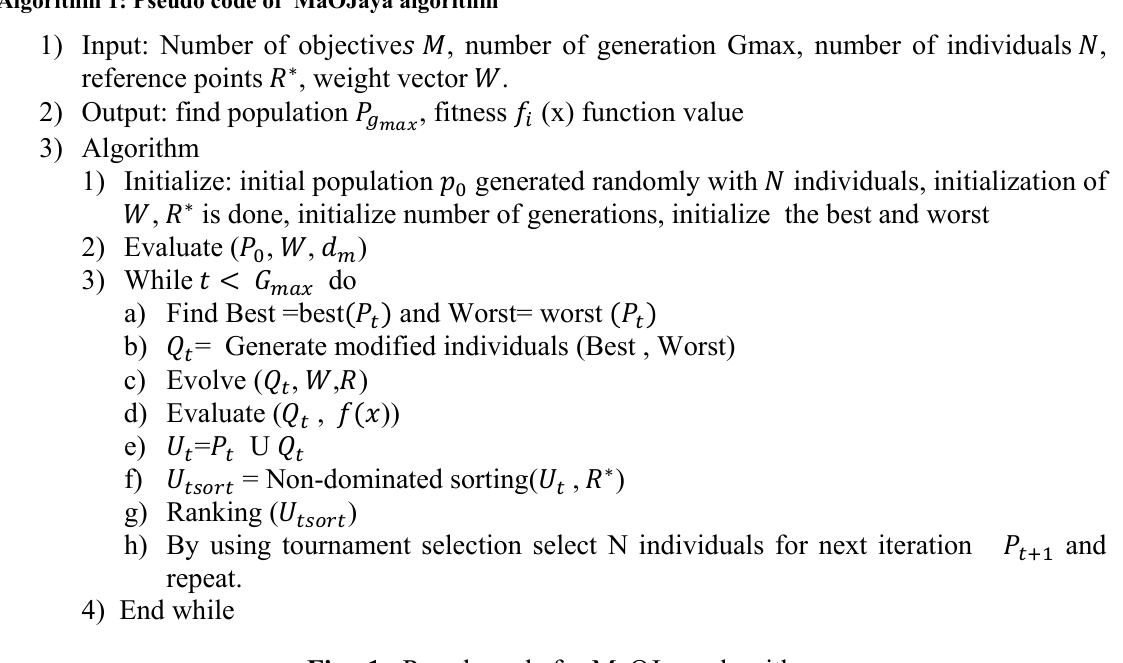
Fig. 1. Pseudo code for MaOJaya